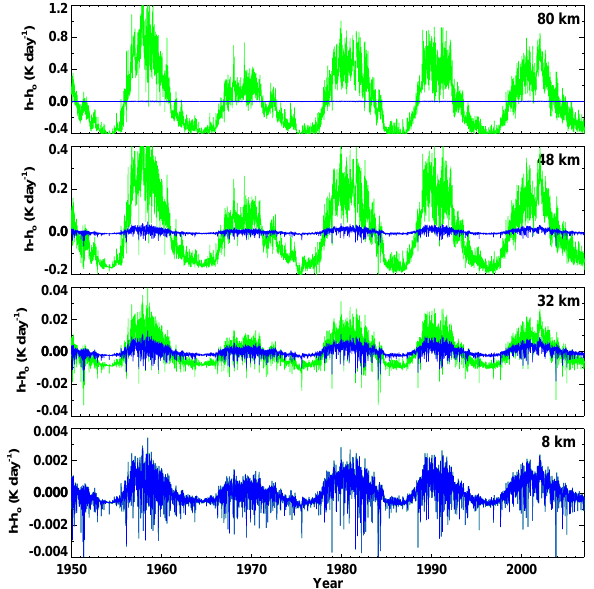
Fig. 1. Time series of the solar heating rate deviation from the 1950–2006 mean values in the troposphere (8km), stratosphere (32km), near the stratopause (48km) and in the upper mesosphere (80km). Blue: variability only in TSI is taken into account. Green: variability in SSI is taken into account. An overhead Sun and equatorial ozone profile are considered in calculating the solar heating rates.